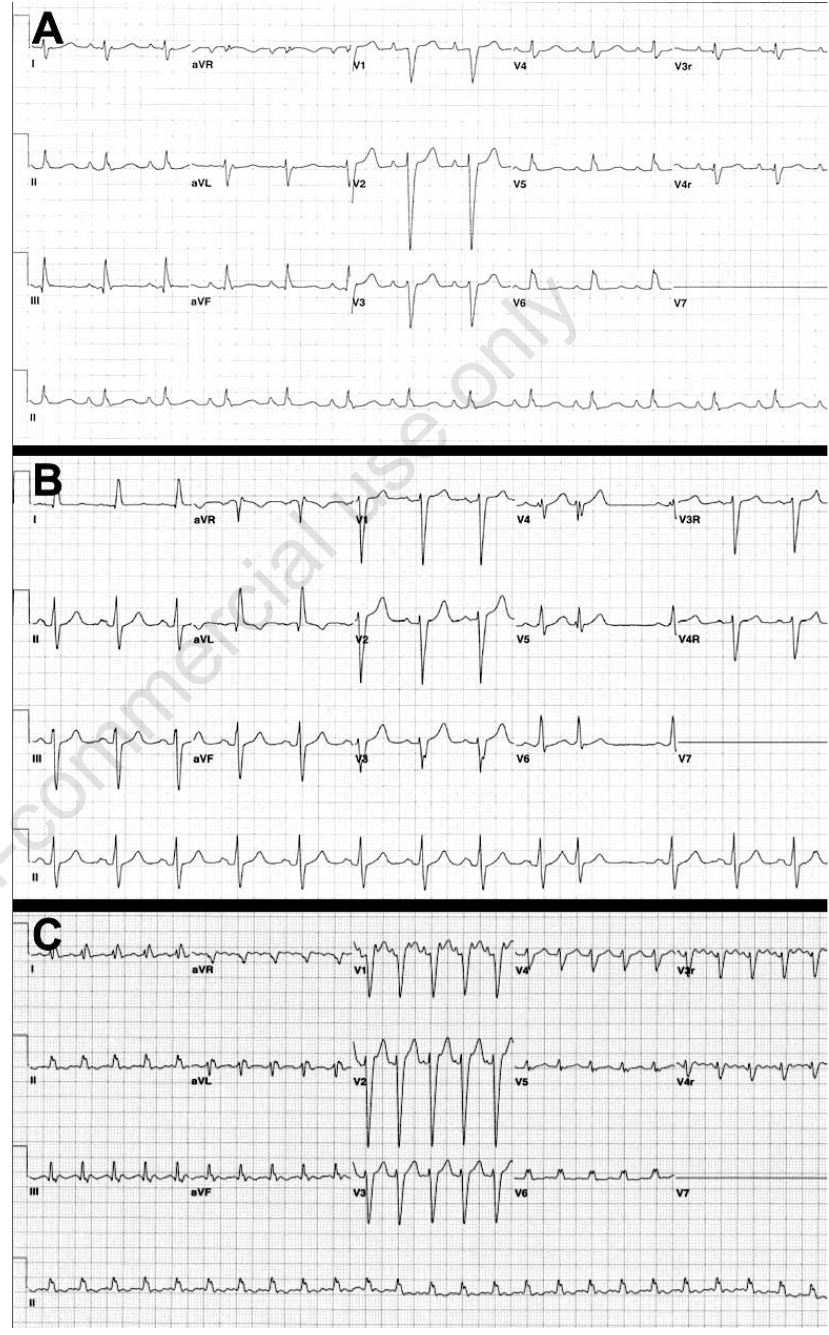
Figure 3. Surface electrocardiograms. A) Case #1. Left bundle branch block pattern with a QRS duration of 142 ms and a PR interval of 200 ms; B) Case #2. Left bundle branch block pattern with a QRS duration of 125 ms; C) Intra-atrial reentry tachycardia in Case #1. Atrial rate of 300 beats per minute with 2:1 atrioventricular conduction and a ventric- ular response rate of 150 beats per